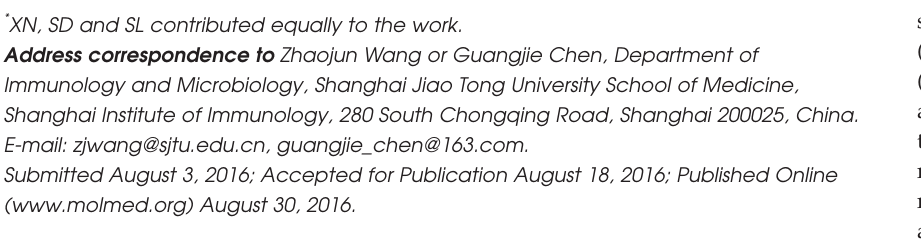
helper T cell (Th) 1 responses and